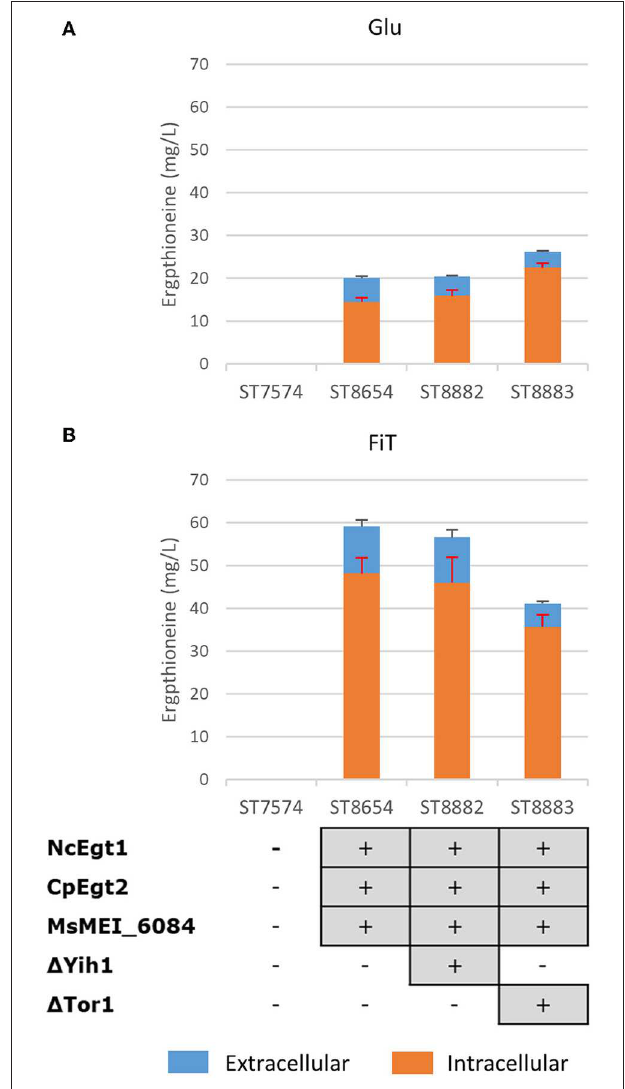
FIGURE 4 | The effect of gene knock-outs linked to nitrogen metabolism on the production of ergothioneine in the production strain with the MsErgT transporter in different media. Genomic alterations are shown as well. (A) Glu: SC + 40 g/l glucose (B) FiT: SC + 60 g/l EnPump substrate, 0.6% reagent